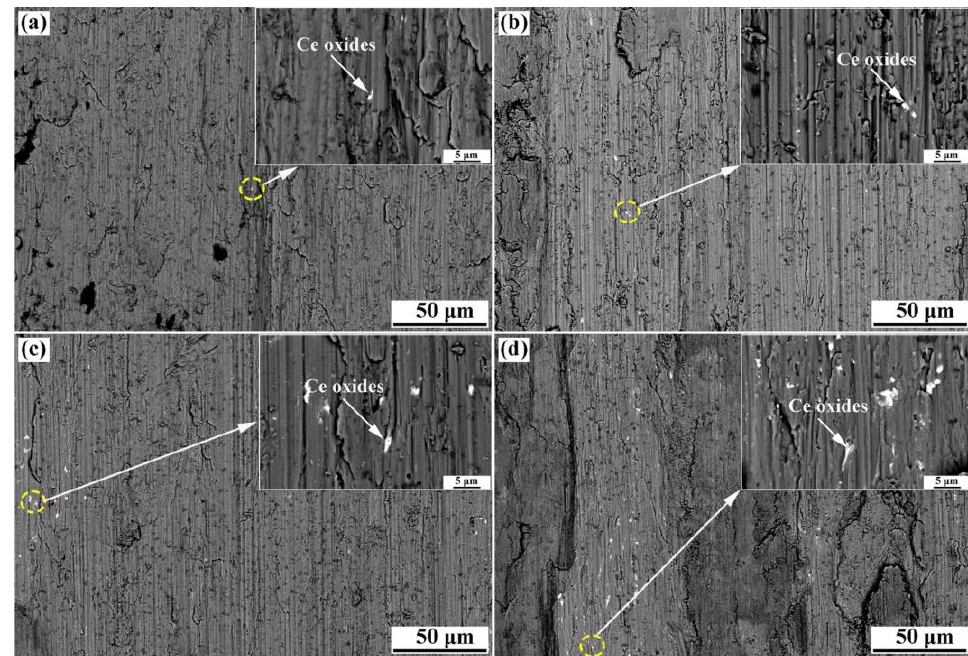
Figure 13. BSE images of the wear morphologies of the composite coatings with various CeO 2 contents: ( a ) 1 wt.%; ( b ) 2 wt.%; ( c ) 3 wt.%; ( d ) 4 wt.%.